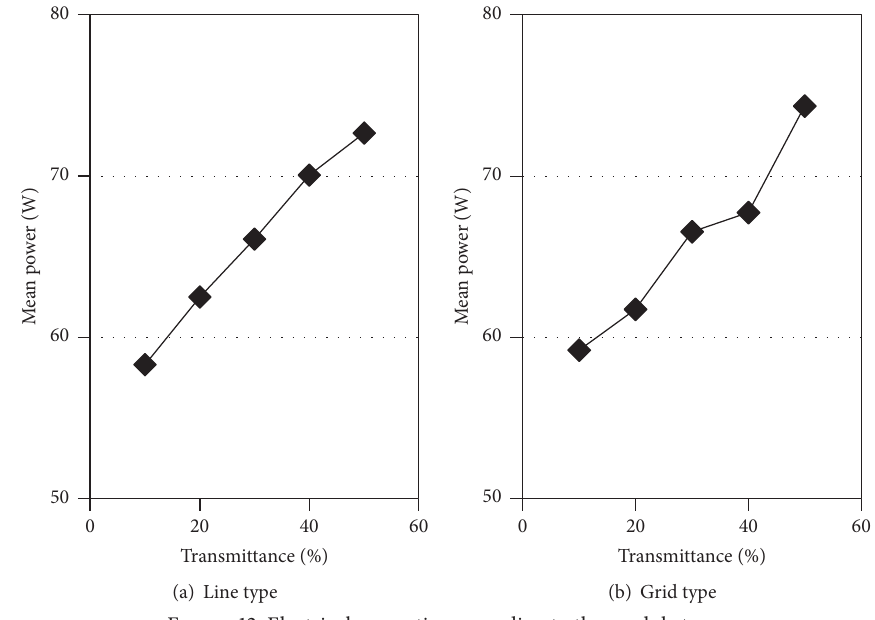
Figure 12: Electrical generation according to the module type.